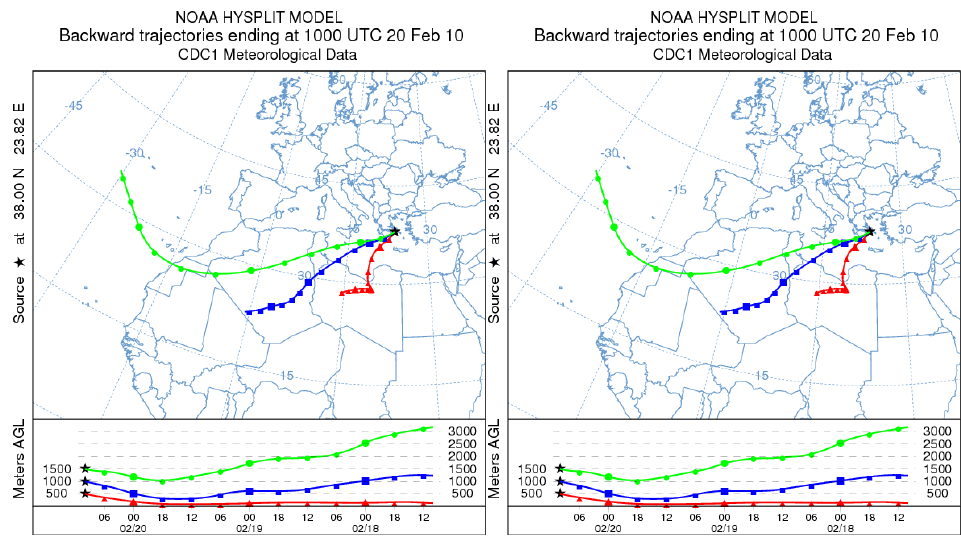
Figure 8. 6 Fig. 8. HYSPLIT back-trajectory analysis at different vertical levels (red: 500m, blue: 1000m, green: 1500m) ending over Barcelona (26 June 2008) and Athens (20 February 2010) showing dust episodes.